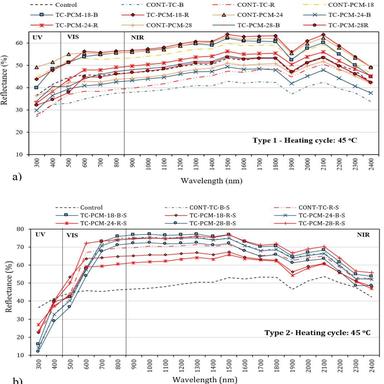
Solar reflectance of samples in the heating cycle.